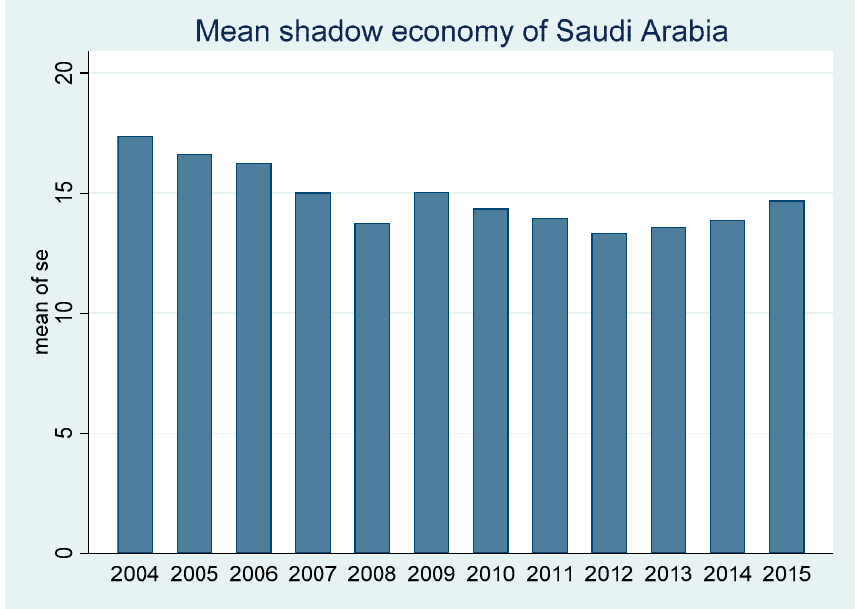
Figure 3. The average size of the shadow economy in Saudi Arabia Source: authors’ estimations.